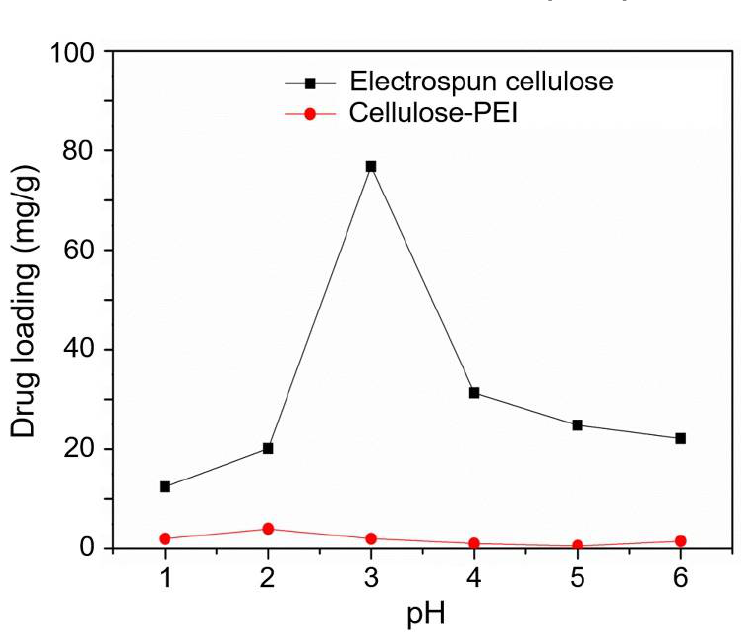
Figure 5. Drug adsorption capacities of the neat electrospun cellulose and cellulose-PEI at different pH values.